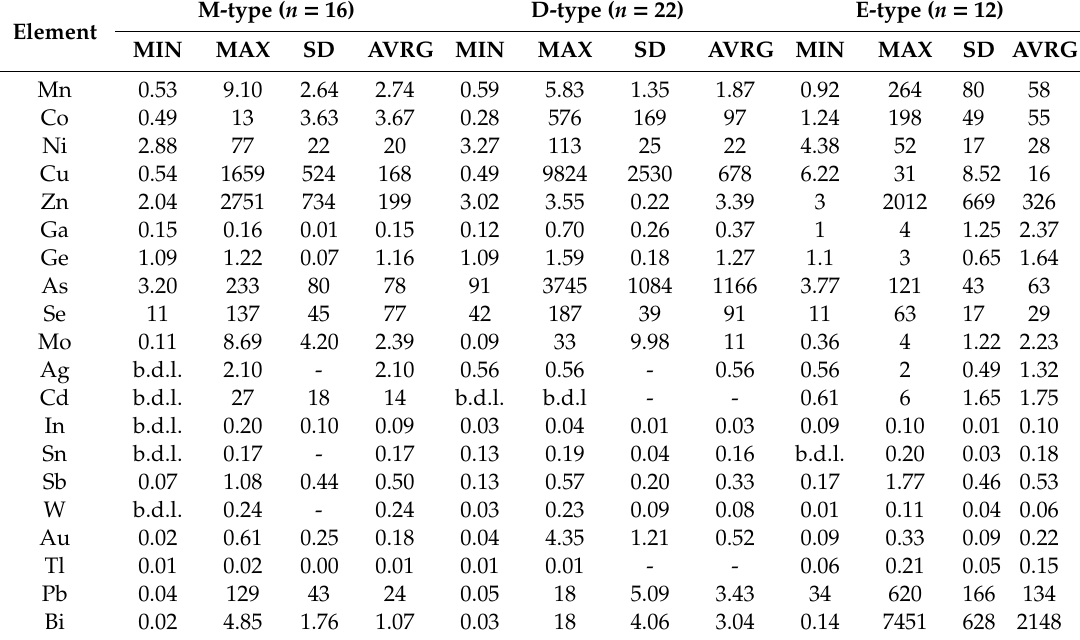
Table 4. LA-ICP-MS analyses of various pyrite generations from the Pagoni Rachi porphyry / epithermal prospect. All values are reported in ppm. For the full dataset please refer to supplementary Table S3.